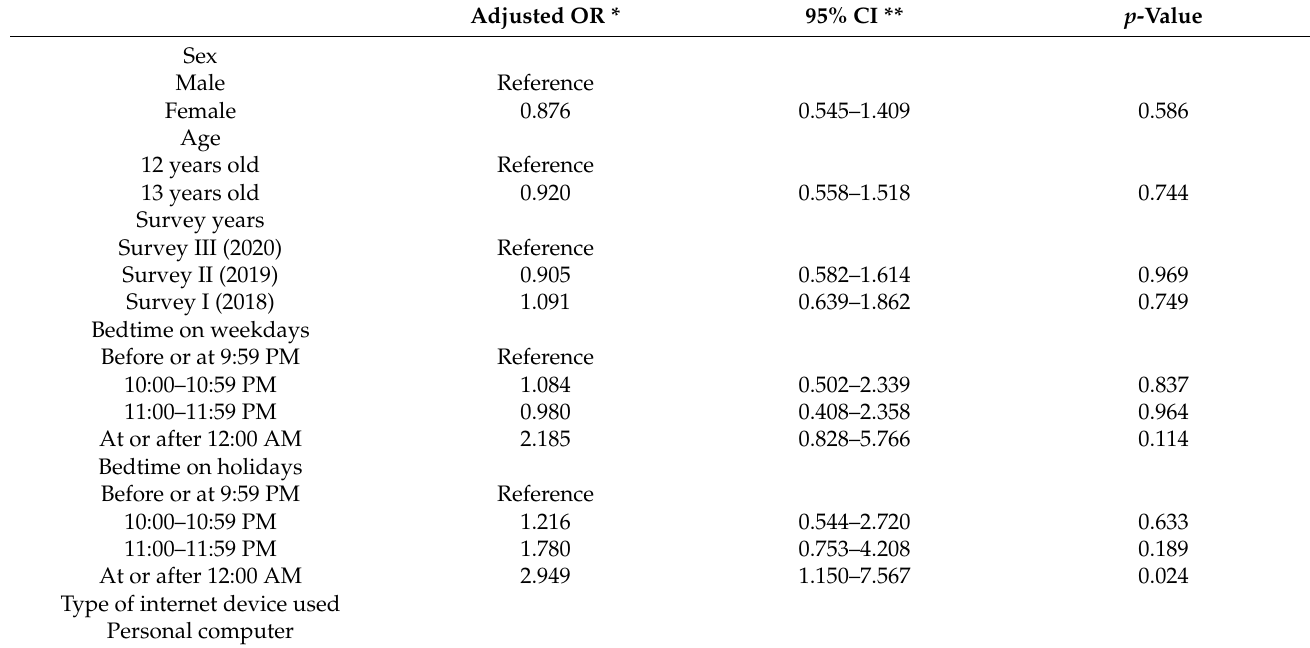
Table 5. Associations between dependent (PIU: YDQ ≥ 5 point) and independent (sex, age, survey years, bedtime on week- day and holidays type of internet device used, and type of internet service used) variables in the logistic regression